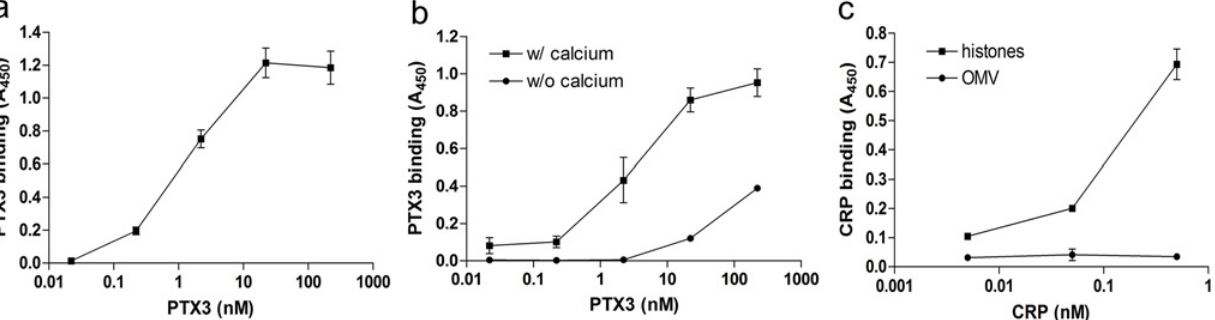
Fig 2. Interaction of PTX3 with OMV. Microtiter plates were coated with OMV (1 μ g/well) and binding of PTX3 (a, b) or CRP (c) is presented as mean absorbance at 450 nm (A 450 ) ± SD of triplicate wells. For each experimental setting data are from one out of three independent experiments. a) dose response of bPTX3; b) binding of bPTX3 to coated OMV in the presence or absence of calcium; c) Interaction of CRP with OMV. Microtiter plates were coated with 1 μ g/well of OMV or Histone H1 (used as positive control for CRP binding), and incubated with different doses of